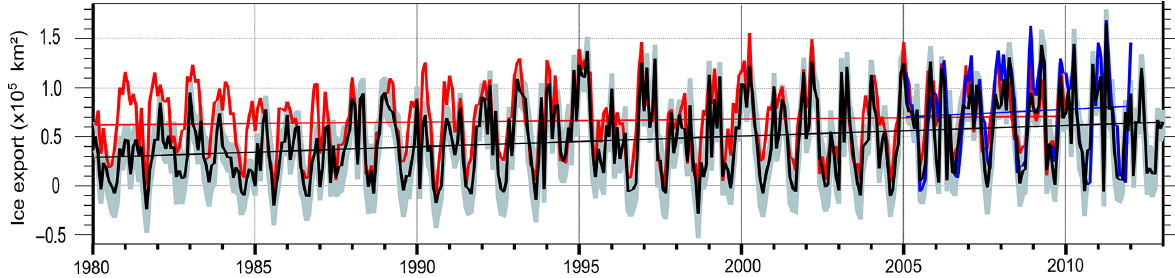
Figure 7. Monthly ice area export (given in × 10 3 km 2 ) across Fram Strait. The black line presents area fluxes calculated from NSIDC drift and concentration information across the meridional and zonal gates (compare Fig. 1). In gray, the corresponding uncertainty estimates are given. The blue and red lines indicate monthly sea ice area transports across 79 ◦ N, 15 ◦ W and 79 ◦ N, 5 ◦ E based on SAR images (Kloster and Sandven, 2011) and based on SLP gradients (Smedsrud et al., 2011), respectively. Trend lines for individual flux estimates are plotted on top.